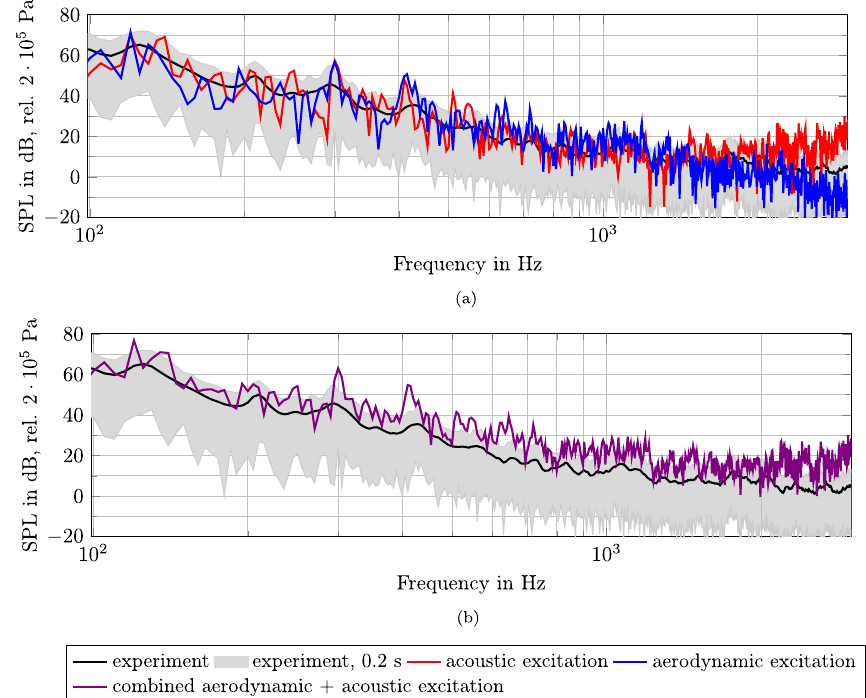
Figure 14. Contribution of acoustic and aerodynamic pressure excitation to overall simulated SPL at driver ’ s ear and comparison to experimental